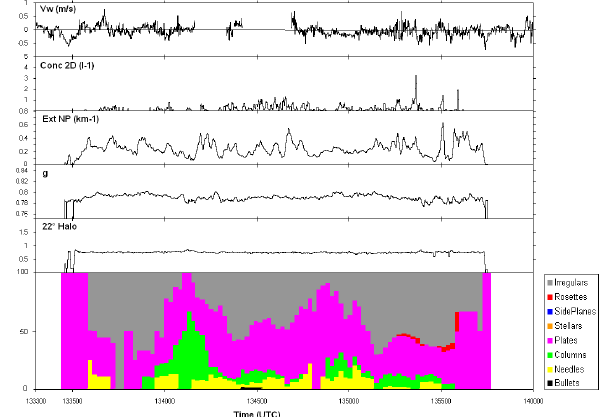
Fig. 1. Time-series of in situ parameters obtained on 16 May in cirrus cloud at 12000/ − 59 ◦ C and 11600m/ − 55 ◦ C levels. Vw: vertical component of the airspeed, Conc2-D: concentration of ice particles with d > 100µm (from 2D-C data), ExtNP: extinction co- efficient, g : asymmetry parameter, 22 ◦ Halo ratio (see text) and CPI particle shape classification for ice crystals larger than 20µm (av- eraged over 5s and expressed in percentages for each category, see legends on the right side of the